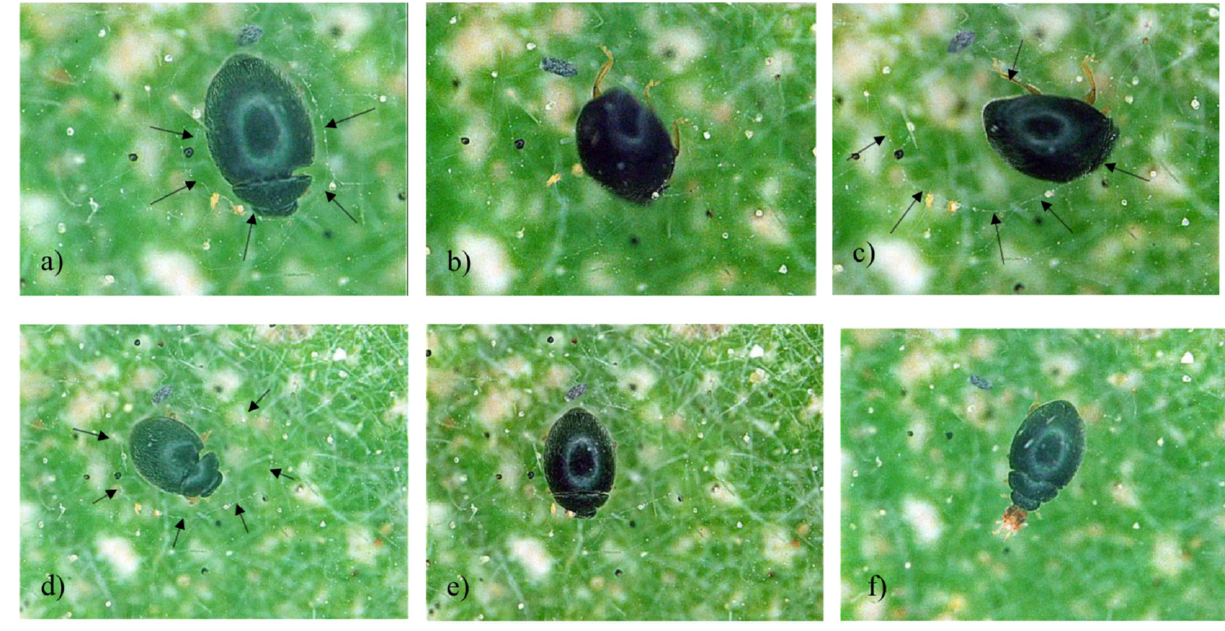
Figure 3. The specialist mite predator Stethorus gilvifrons coping with the web of the avocado brown mite, Oligonychus punicae : ( a ) predator feeding on female mite outside the web; ( b ) predator cutting web threads over the egg. Arrow indicates eggs covered with web threads.